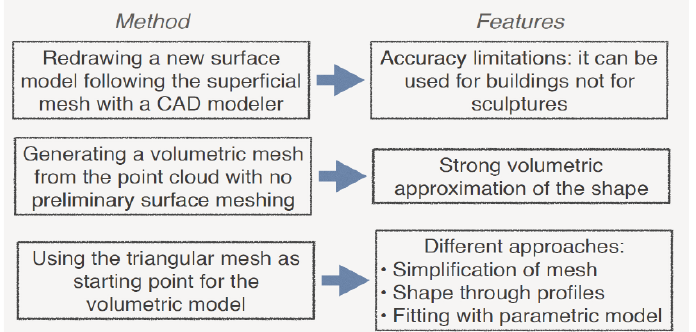
Figure 1. Pros and cons of the different processes used for the generation of volumetric models of cultural heritage for FEA. cultural heritage for